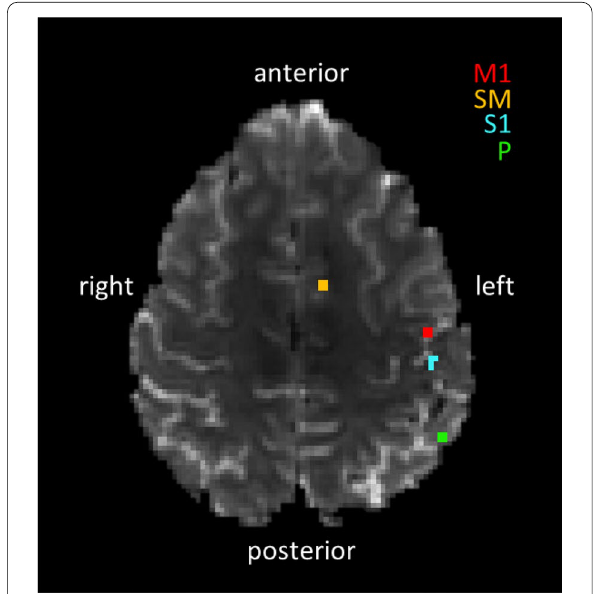
Fig. 1 ROIs drawn on one representative subject, representing primary somatosensory (S1), primary motor (M1), supplementary motor (SM) and parietal (P)